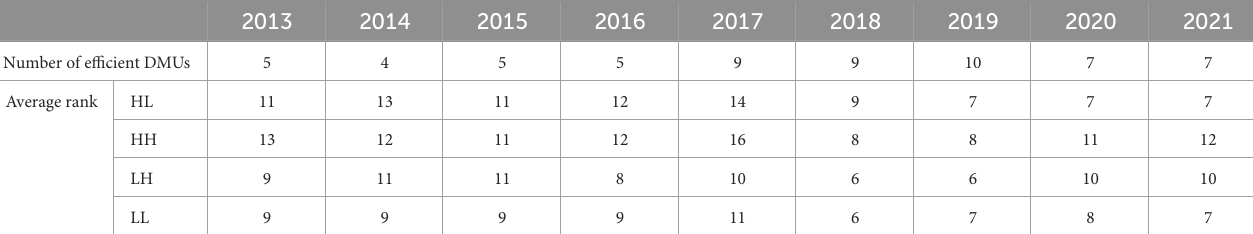
TABLE 4 Number of efficient DMUs during